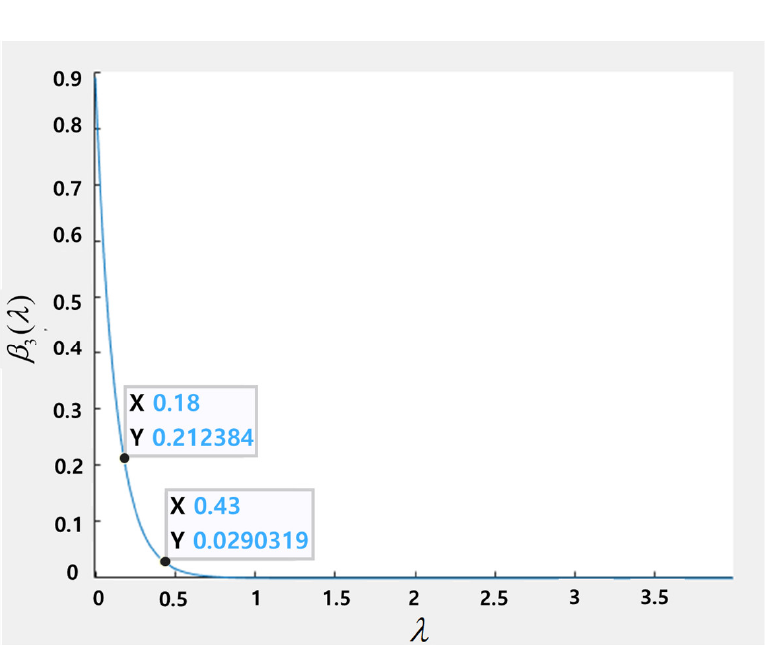
Figure 13. β  (λ) according to Equation (40). Figure 13. β ( λ ) according to Equation 3